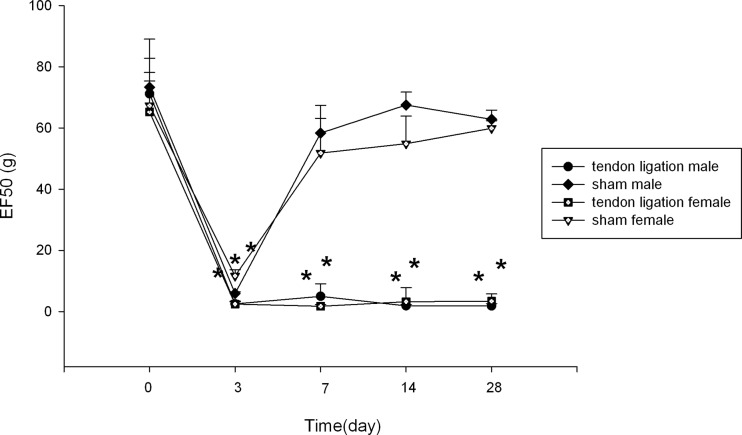
Mechanical allodynia following ligation of the masseter tendon.The EF50 were derived from the respective stimulus-response frequency function curves. A significant reduction of EF50 suggested the presence of mechanical allodynia. All data are shown as mean ± SE and each group consisted of 6 animals. * denotes significant effects with respect to the baseline at p < 0.05.